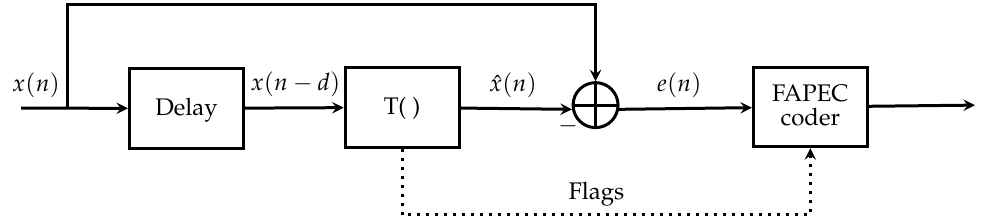
Figure 6. The FAPEC data compressor